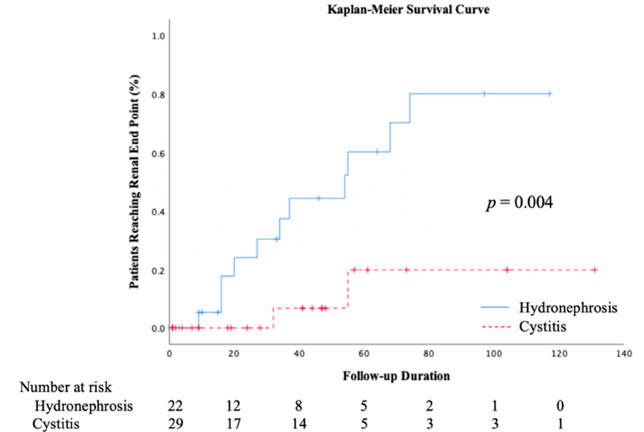
Figure 3. Progression of ketamine uropathy by hydronephrosis status. The Kaplan–Meier curves show the cumulative probability of reaching the renal endpoint of a 30% decline in the glomerular filtration rate or progression to end-stage renal disease among patients with ketamine uropathy, stratified according to hydronephrosis status. Table 3 presents the results of the multivariate analysis to evaluate possible risk factors associated with renal outcome among ketamine-associated uropathy patients. The occurrence of risk of renal function deterioration was 5 times higher for patients with hydronephrosis than for those with cystitis alone (95% confidence interval, 1.128 to 25.137). Table 3. Multivariate analysis of risk factors associated with renal outcome among ketamine uropathy patients using a Cox proportional hazards model.